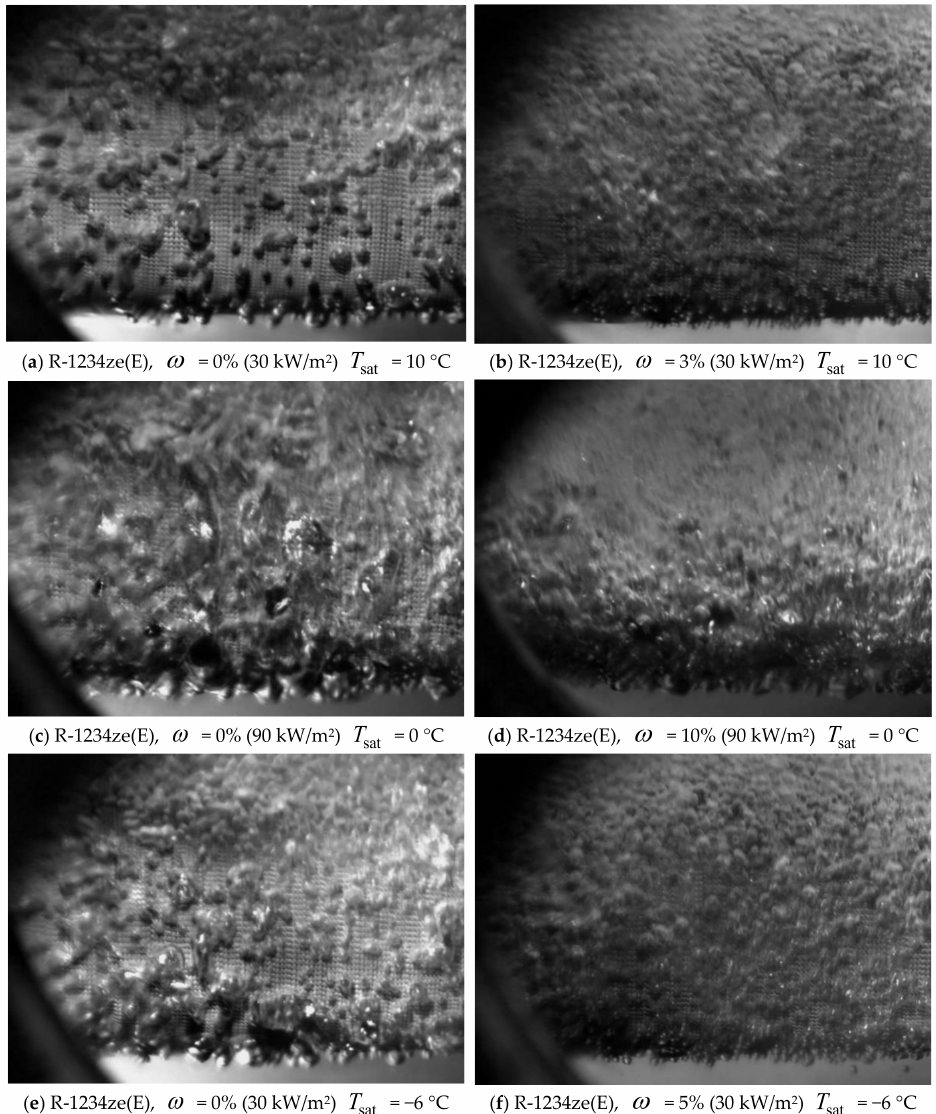
Figure 8. Effect of lubricant oil on bubble size and nucleation sites at different saturation temperatures and heat